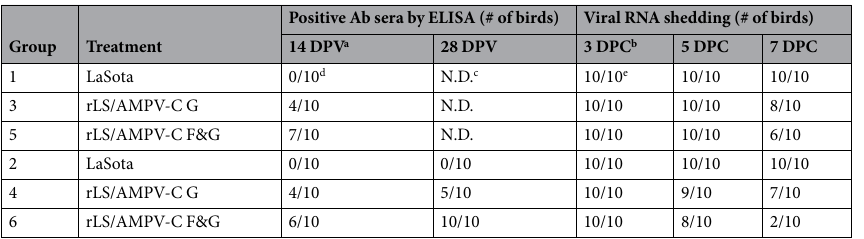
Table 2. Serum antibody response against AMPV-C following vaccination and AMPV-C virus shedding in trachea following challenge. a DPV: days post-vaccination. b DPC: days post-challenge. c N.D.: not determined. d Number of birds shedding viral RNA/total number of birds tested. e Number of birds with positive ab/total number of birds